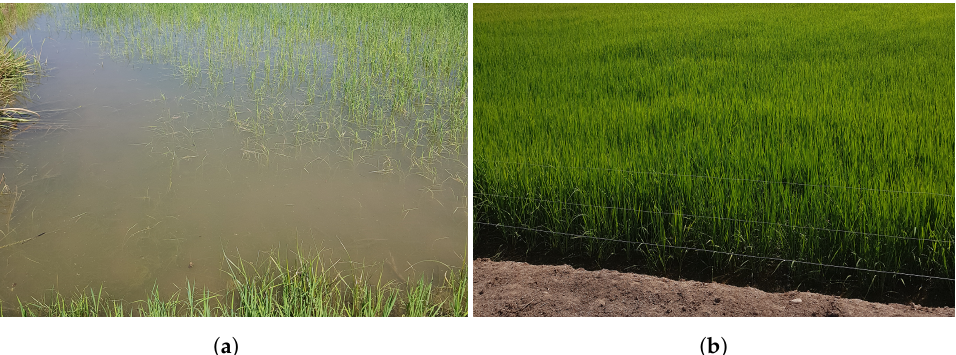
Figure 2. Most representative stages of rice cultivation in the study area. ( a ) Flooded plot. ( b ) Plot in growth